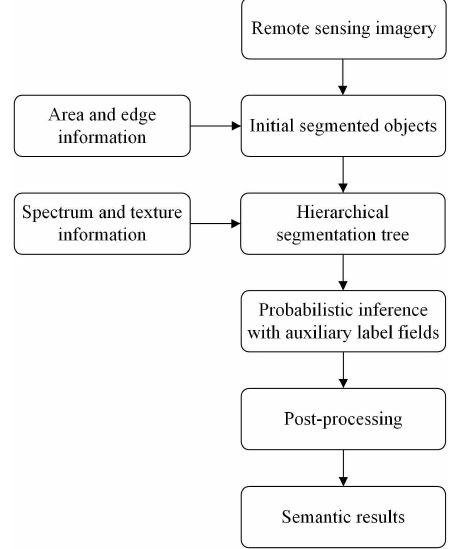
Figure 1. Flow diagram of Object-based Markov Random Field based on hierarchical segmentation tree with auxiliary labels (OMRF-HA).